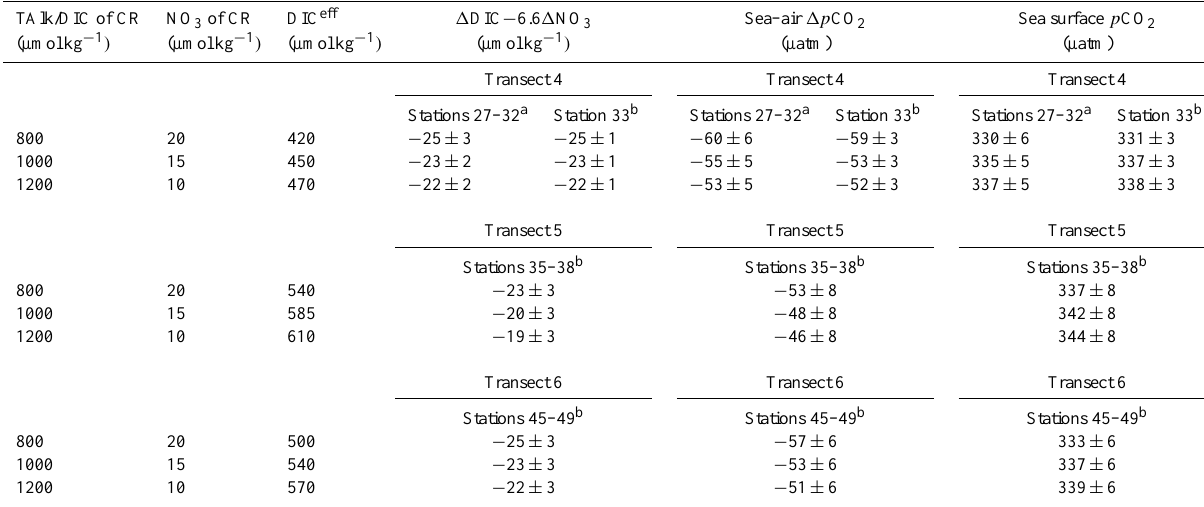
Table 1. Values of (cid:49) DIC − 6.6 (cid:49) NO 3 , sea–air (cid:49)p CO 2 and sea surface p CO 2 estimated with different DIC eff , which is the combined fresh- water end member of DIC partly sourced from the Columbia River (CR).